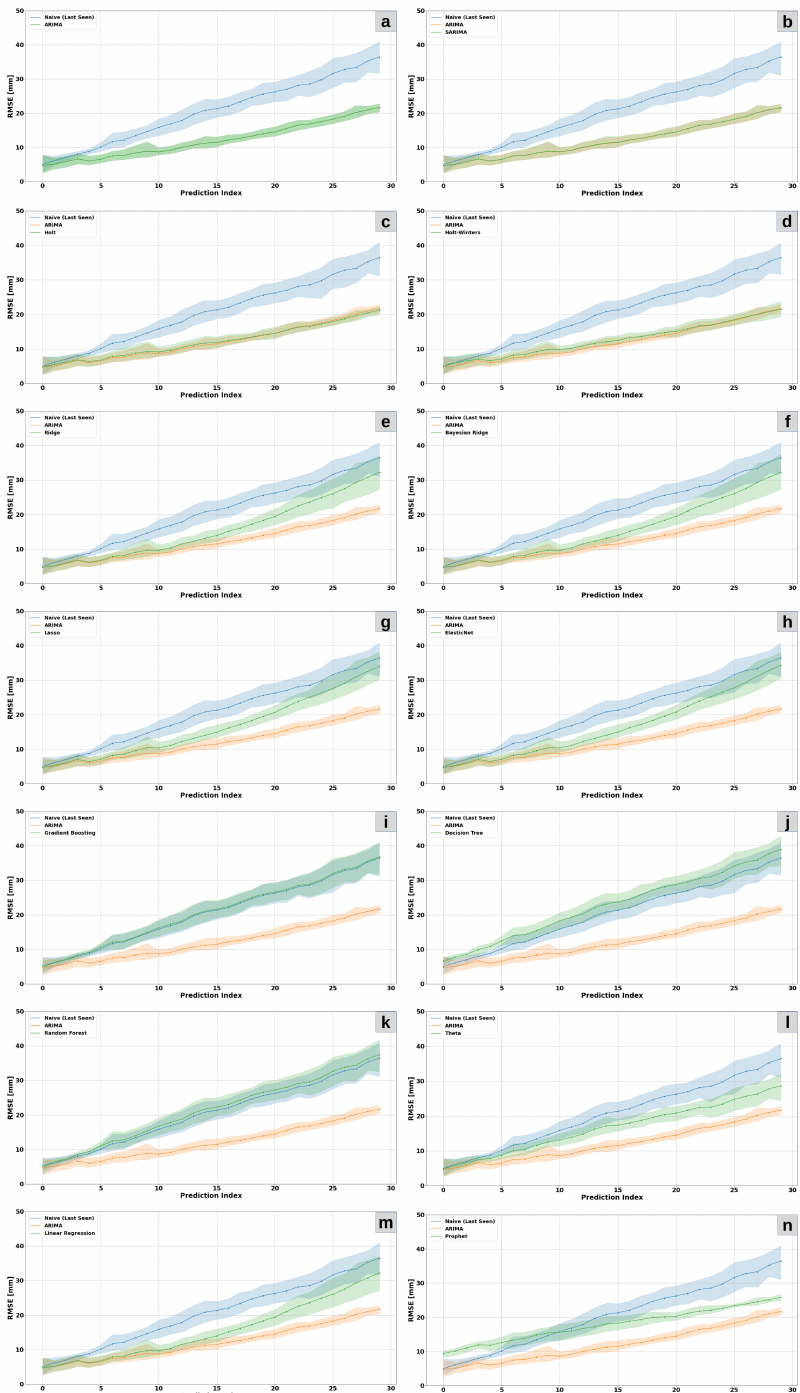
Figure 9. RMSE calculation results on the basis of the data from all points for a particular prediction window (Equation (B) from Figure 4). The accuracy of the model is visually represented as a function of time (forecasting horizon). For reference, each of the plots includes the results of the Naive approach (baseline) and of the ARIMA model which provided the best results. The plots present the mean from all cross-validation groups (solid line) for a particular prediction window, along with its 95% confidence interval in the form of a ribbon around the mean. The following plots present the results for ( a ) ARIMA model, ( b ) SARIMA model, ( c ) Holt model, ( d ) Holt-Winters model, ( e ) Ridge model, ( f ) Bayesian Ridge model, ( g ) Lasso model, ( h ) ElasticNet model, ( i ) Gradient Boosting, ( j ) Decision Tree, ( k ) Random Forest, ( l ) Theta model, ( m ) Linear Regression model and ( n ) Prophet model,